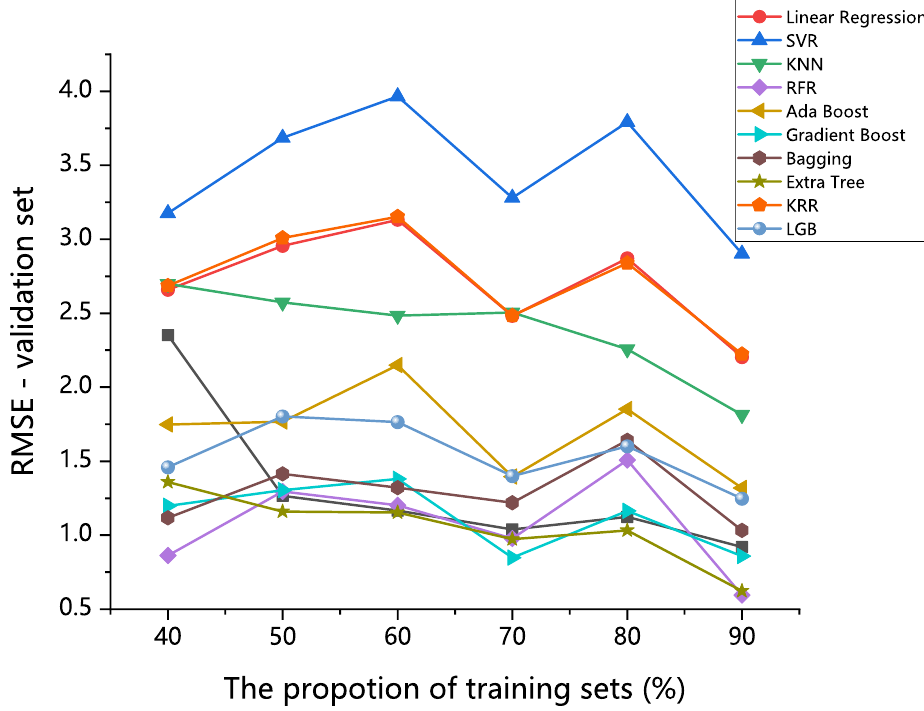
Figure 2. Predictive performance of the decision tree, linear regression, SVR, KNN, KRR, RFR, AdaBoost, gradient boost, bagging, extra trees, and LGB algorithms in different training set division ratios.